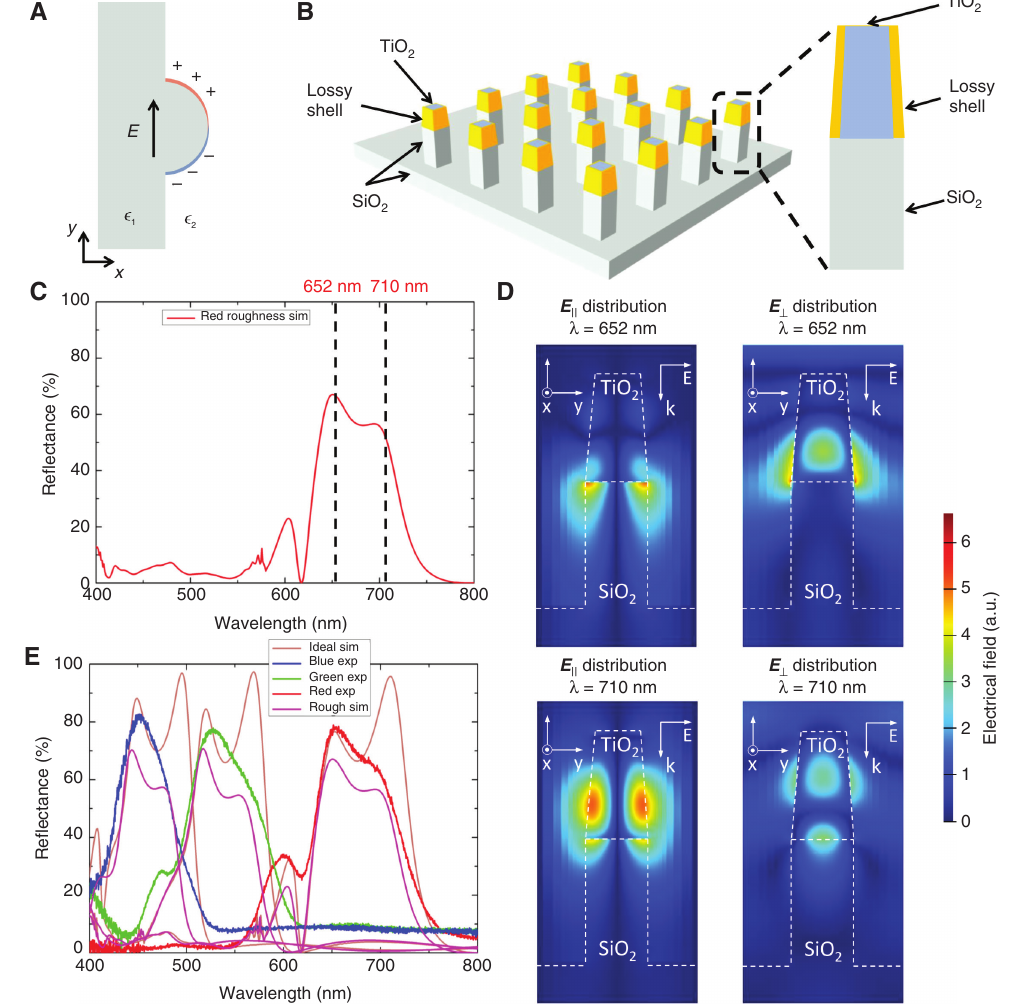
Figure 3: Effects of metasurface roughness. (A) A “bump” on the interface between two materials e (TiO ) and e (background). An applied electric field E will induce a dipole moment on 1 2 2 the surface (blue/red color denotes positive/negative charge). (B) Schematic of all-dielectric metasurface with a lossy shell. The 5-nm-thick lossy shell is outside the TiO layer. (C) Calculated reflection spectrum of the all-dielectric metasurface with the lossy shell 2 (B) at normal incidence. (D) Electrical field component ( E or E ) distributions of the all-dielectric metasurface with the lossy shell (B) at ⊥ ‖ different wavelengths (652 or 710 nm) in the YZ -plane. (E) Calculated reflection spectra of the ideal all-dielectric metasurfaces (Figure 1A), measured reflection spectra of the fabricated all-dielectric metasurfaces (Figure 1B and C), and calculated reflection spectra of the all- dielectric metasurface with the lossy shell (B). All spectra are at normal incidence. It is obvious that the calculated reflection spectra of the all-dielectric metasurface with the lossy shell are much closer to the measured